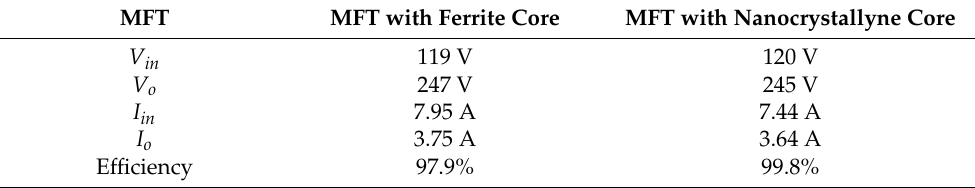
MFT MFT with Ferrite Core MFT with Nanocrystallyne Core